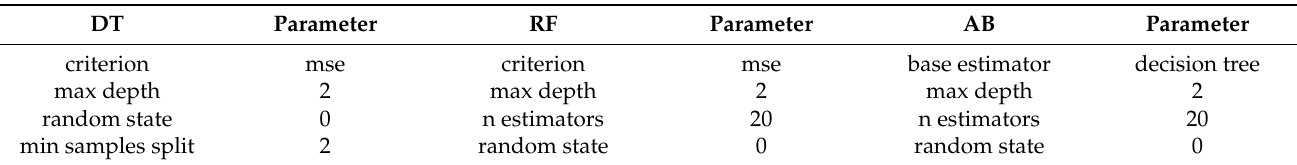
Figure 7. Variation of average RMSE of 10-fold cross-validation with the number of trees ( a ) South China, ( b ) East China, ( c ) North China, and ( d ) East North. The pink area is RMSE variation range of the 10-fold cross-validation for RF algorithm and the blue area is RMSE variation range of the 10-fold cross-validation for AB algorithm. Table 2. The selection of key hyperparameters.